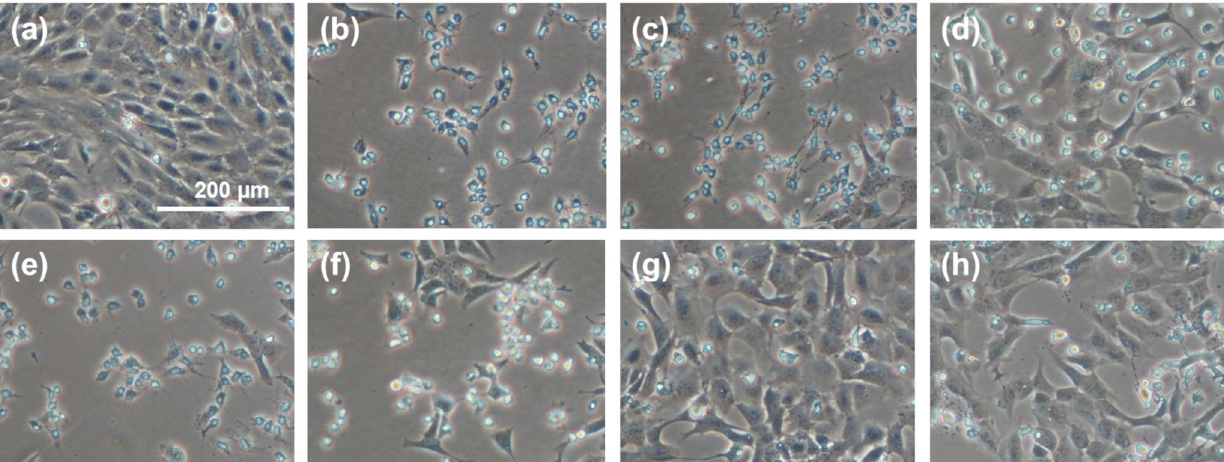
Figure 6. Micrographs of randomly selected cell growth areas illustrating the effect of supplemental sericin fractions on the proliferation and morphology of 661 W murine retinal photoreceptor cells under oxidative stress induced by hydrogen peroxide (H202, 1.2 mM by total media volume). ( a ) Control (no sericin, no oxidant); ( b ) control (no sericin, +oxidant); ( c ) CS, 1 mg/mL (+oxidant); ( d ) CS, 5 mg/mL (+oxidant); ( e ) PS, 1 mg/mL (+oxidant); ( f ) PS, 5 mg/mL (+oxidant); ( g ) CS-E, 1 mg/mL (+oxidant); ( h ) CS-E, 5 mg/mL (+oxidant). The scale bar in ( a ) is the same for all images.